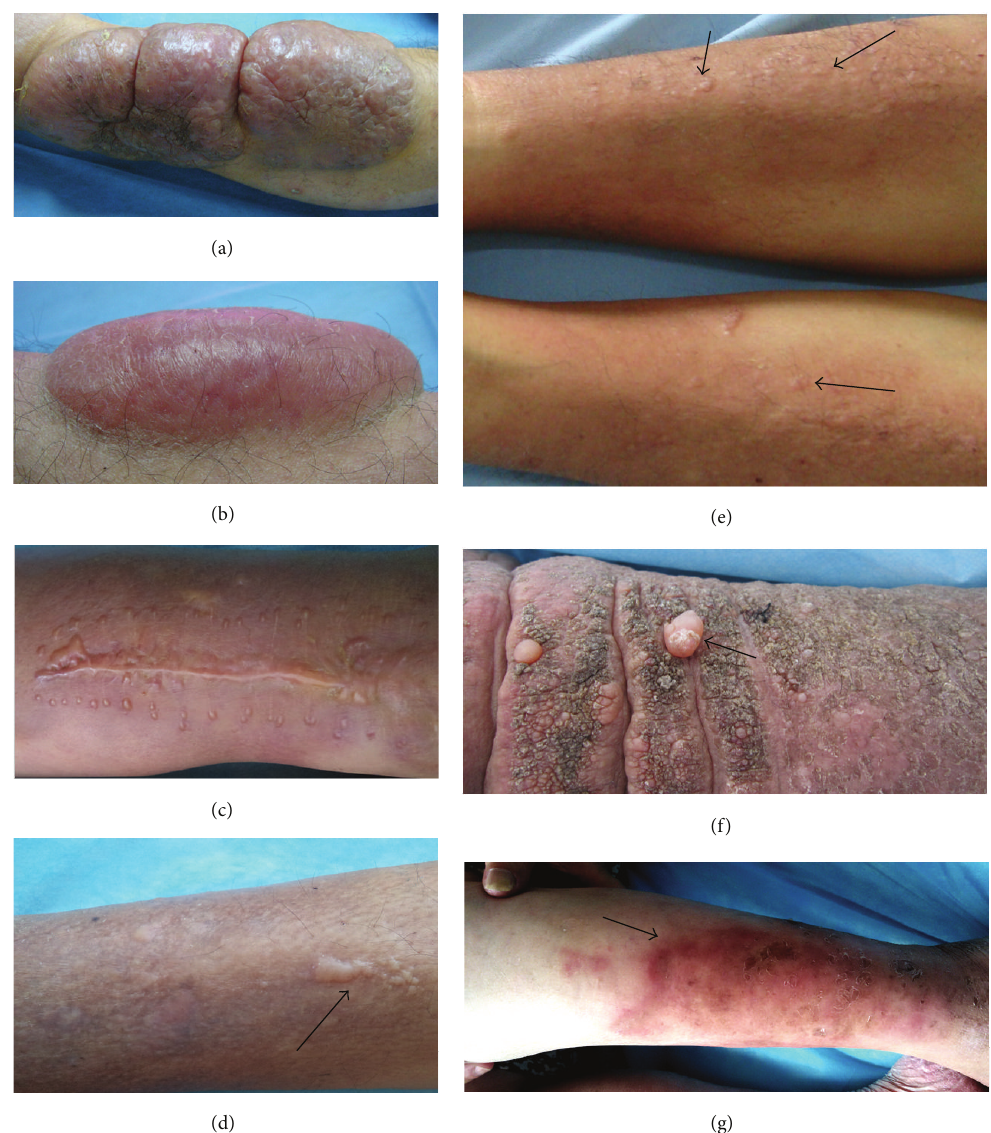
Figure 7: Active stage. (a) Red, crusted (after itching scratch), tense, and semitranslucent appearance of lobulated tumors on the lower leg. (b) Red, tense, and semitranslucent appearance of a smooth tumor on the lower leg. (c) New-formed, hypertrophic-scar-like papules and plaques on the lower leg when PTM was active at the healing wound site after trauma and suture. (d) An arrow indicated new-formed papules and plaques on the active lesions of PTM on the lower leg. (e) Arrows indicated new-formed, red papules on the active lesions of diffuse swelling variant at the lower legs. (f) An arrow indicated tense, pearl-like papule and nodule on the active elephantiasis with dry, papillary appearance on the lower legs. (g) An arrow indicated irregular, scarlet, and swelling erythema on the legs when PTM recurred.